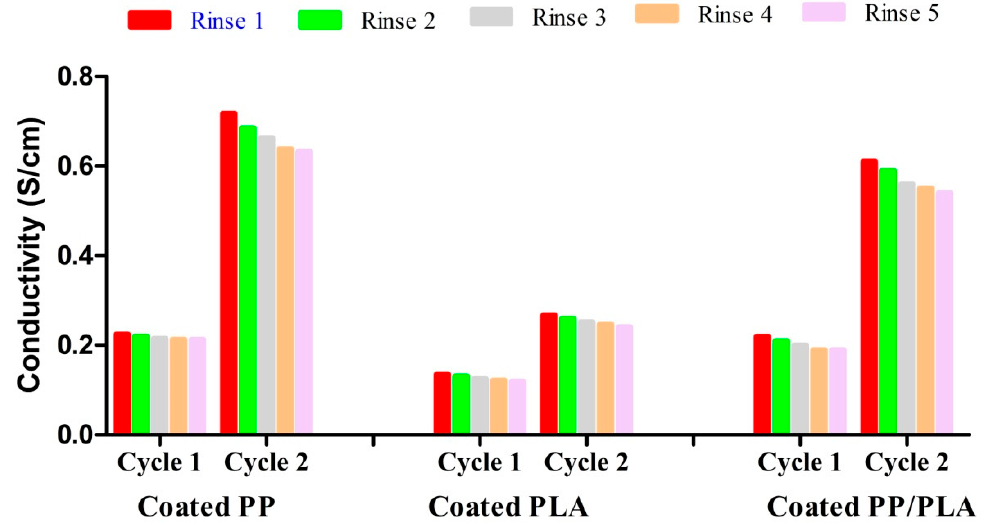
Figure 14. Conductivity (S/cm) of PEDOT:PSS coated PP, PLA and PP/PLA yarns after rinsing.